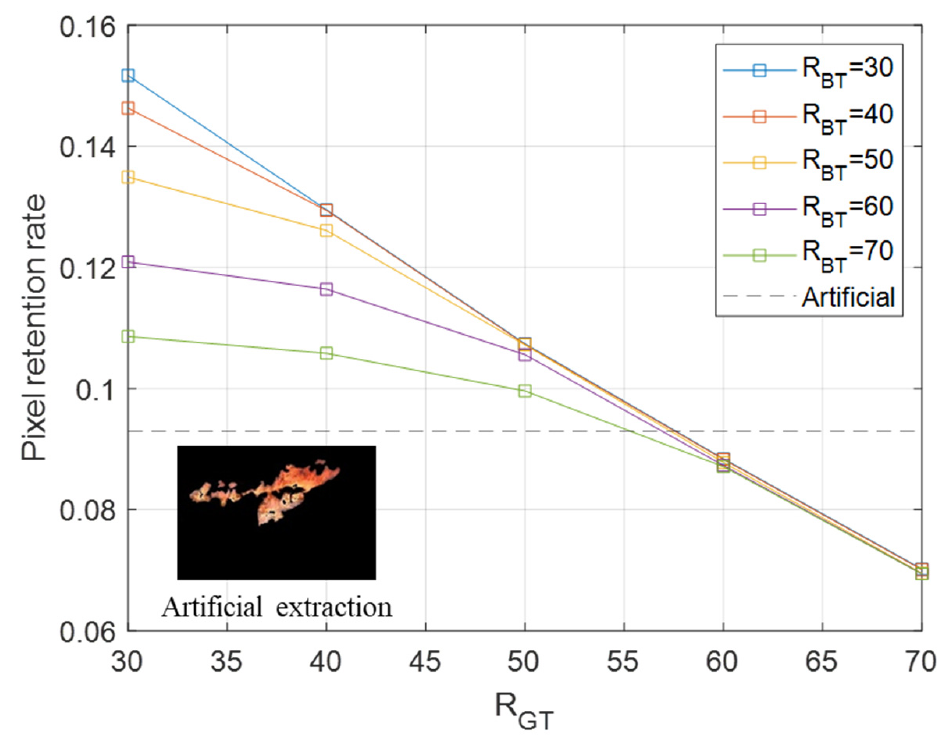
Figure 3. The relationship between R GT , R BT , and pixel retention rate.